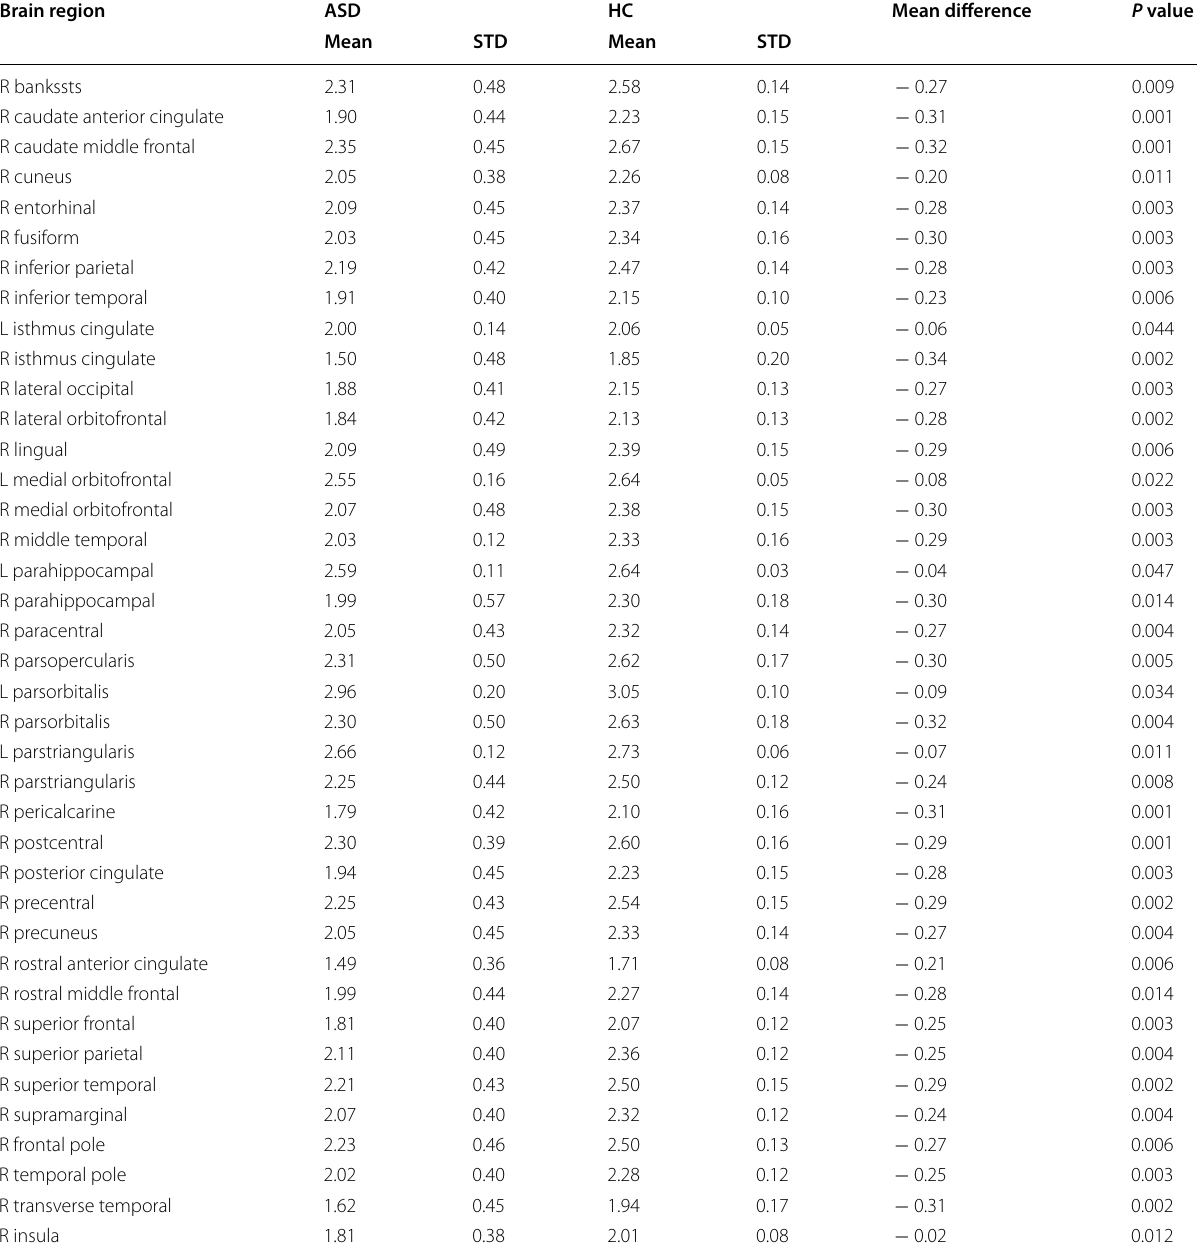
ASD Autism Spectrum Disorder, HC Healthy Controls, STD Standard Deviation, L Left, R